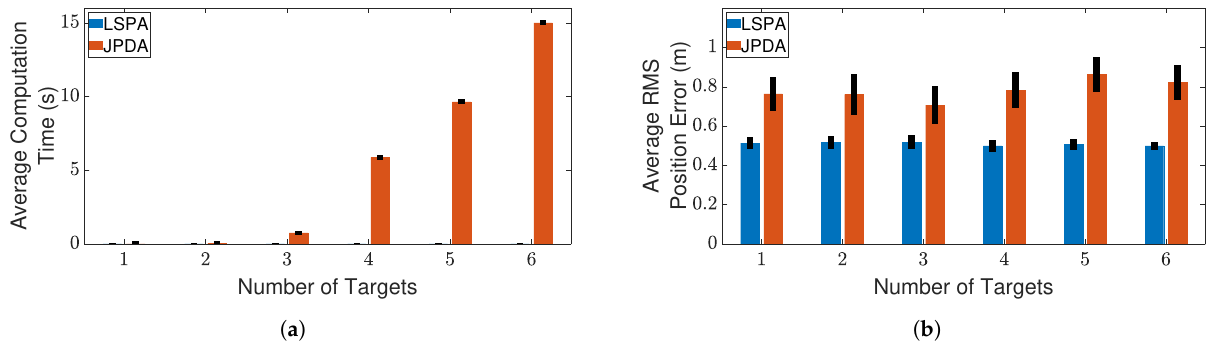
Figure 8. Tracking multiple crossing targets using loopy sum-product algorithm (LSPA) and joint probabilistic data association (JPDA) with clutter density λ = 5 × 10 − 4 / m 2 . ( a ) Average computation time for obtaining association probabilities; ( b ) average root mean square (RMS) position error. Error bars indicate 95% confidence